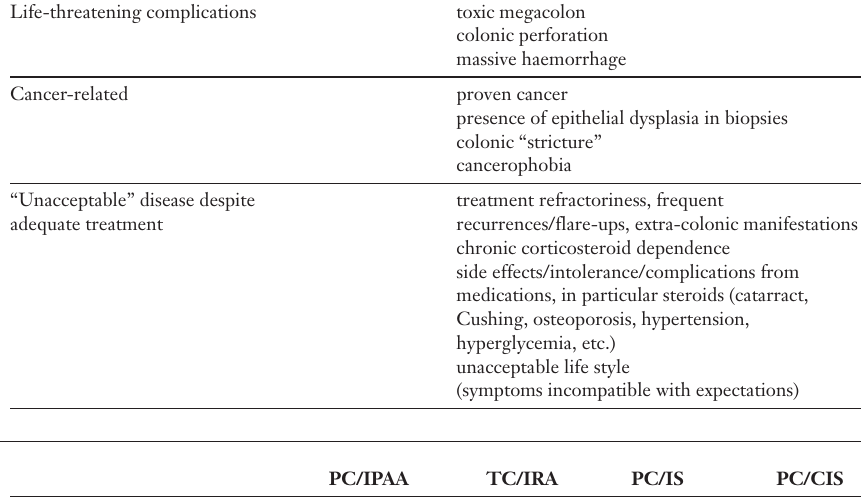
Summary of the four surgical options, compared with re- gard to their advan- tages and disadvan- tages. For abbrevia- tions: see